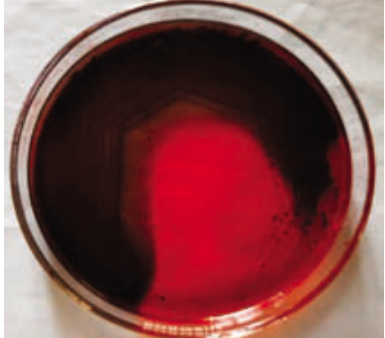
Fig. 5. Inhibition of biofilm by berberine in combination with enrofloxacin